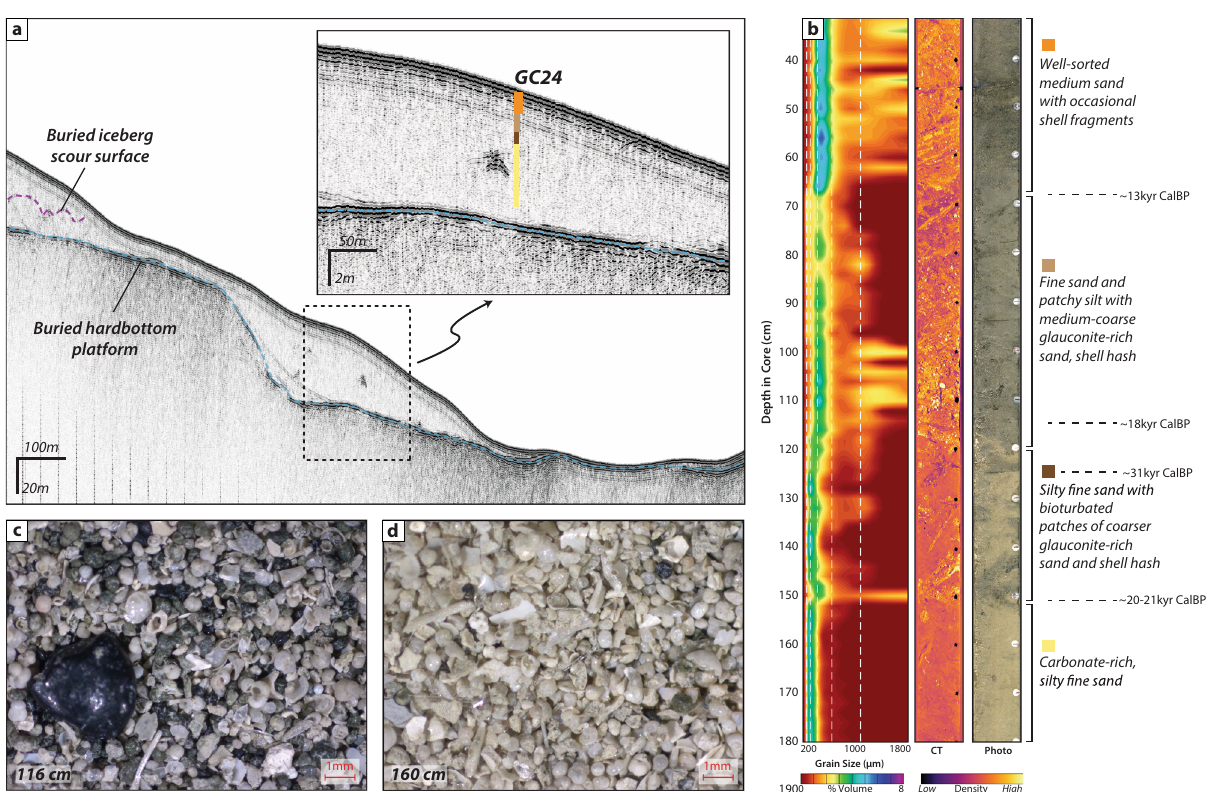
Fig. 5 Sedimentology and stratigraphy of nearby unscoured region. Core GC24, collected in a deeper portion of the depocenter, where no iceberg scours are observed, also shows distinct variations in grain size and lithology that correspond in time to the changes observed in the cores collected from within iceberg scours. a Chirp subbottom pro fi le across the core location; b Grain size, false-color CT scan, and core photograph of the middle section of GC24; c , d Microscope photographs of coarse fraction (>63 μ m) samples showing coarser grains with increased glauconite that occur after ~31 kyr cal BP, relative to the older carbonate-rich fi ne